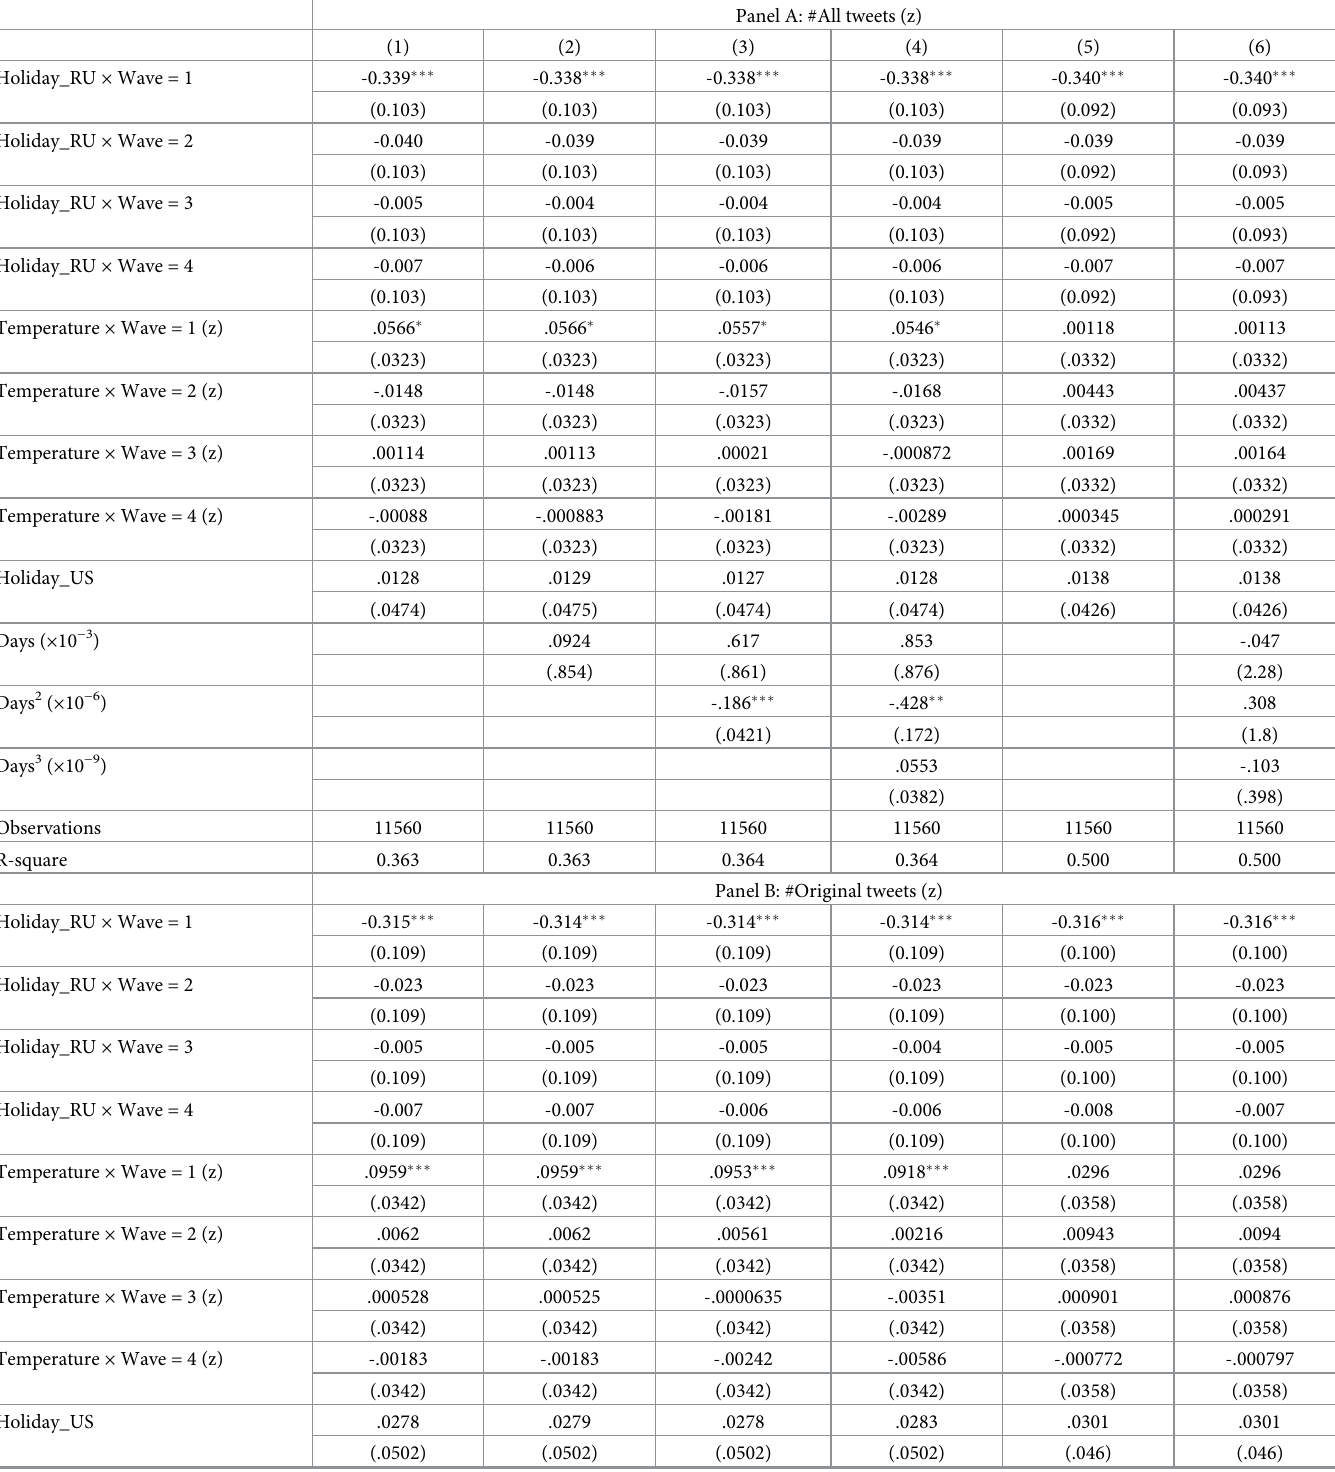
Table 1. First stage: Russian holiday and temperature on blocked tweets on the day